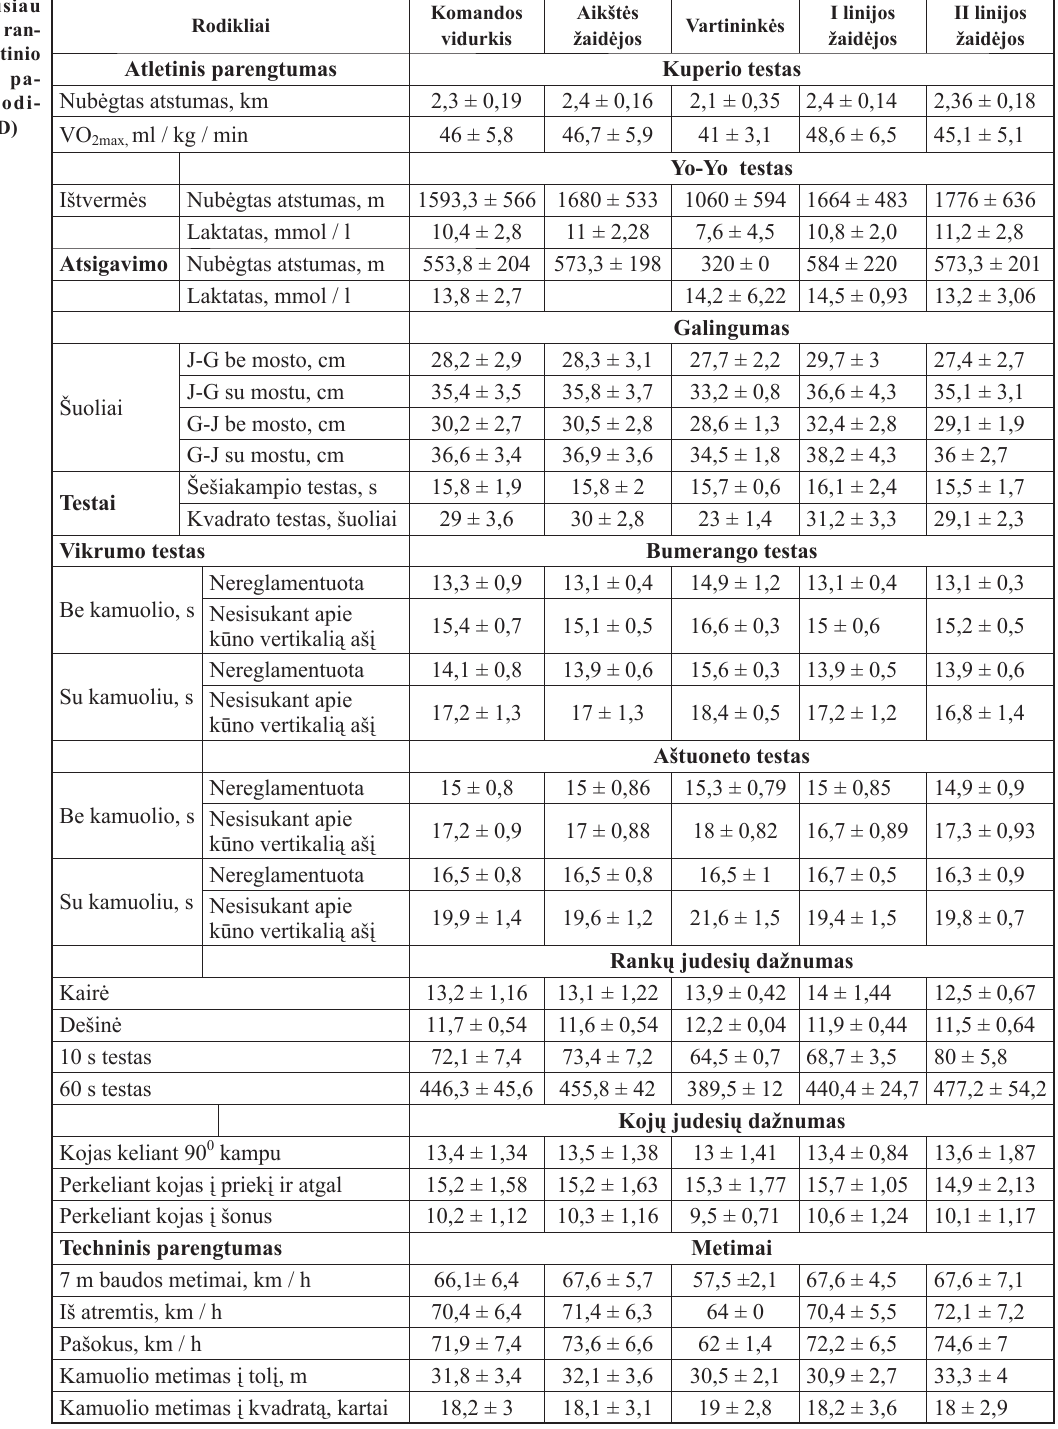
muoliu — II linijos. Atlikdamos nereglamentuot ą Aštuoneto test ą tiek su kamuoliu, tiek be jo, grei- tesn ė s buvo II linijos žaid ė jos. Atlikdamos š į test ą reglamentuotai, I linijos žaid ė jos buvo greitesn ė s nei II linijos. Judesi ų dažnumas. Rank ų judesi ų dažnumas II linijos žaid ė j ų buvo geresnis nei I linijos 2,5 s (kaire) ir 0,5 s (dešine) (3 lent.). Kair ė s rankos judesi ų dažnumas buvo blogesnis nei dešin ė s 1,5